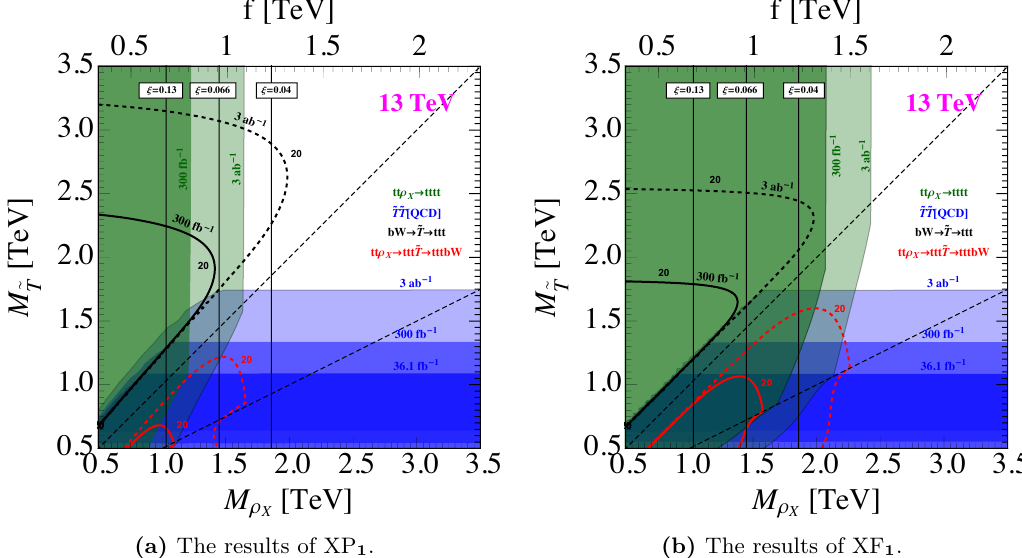
Figure 10. The current limits and prospective reach on model XP 1 (left plot) and model XF 1 (right plot). The parameters are chosen as eq. (3.4). The existing bound and the projections are shown as shaded regions, using e T e T [QCD] in bW + (cid:22) bW (cid:0) channel [74]. The dark green regions come from t (cid:22) t(cid:26) 0 associated production, based on the phenomenological study of ref. [102]. The contours X for N ( ‘ (cid:6) ‘ (cid:6) +jets) = 20 are drawn in solid (dashed) lines for 300 (3000) fb (cid:0) 1 , as a prospective limit for the bW ! e T ! t(cid:26) 0 ( t (cid:22) t ) channel (in black) and t (cid:22) t(cid:26) X ! t (cid:22) tt e T ( bW ) channel (in red). See the main X text for more